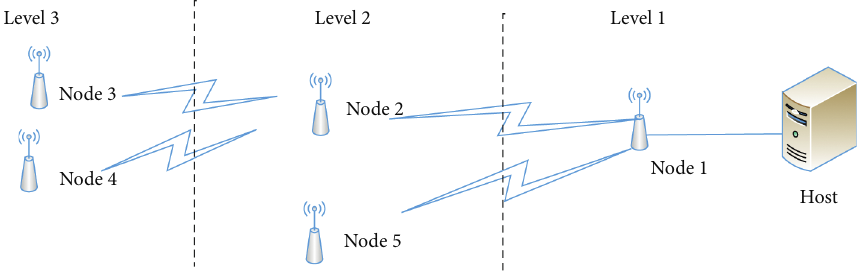
Figure 4: Radioactive material group network with the star structure.